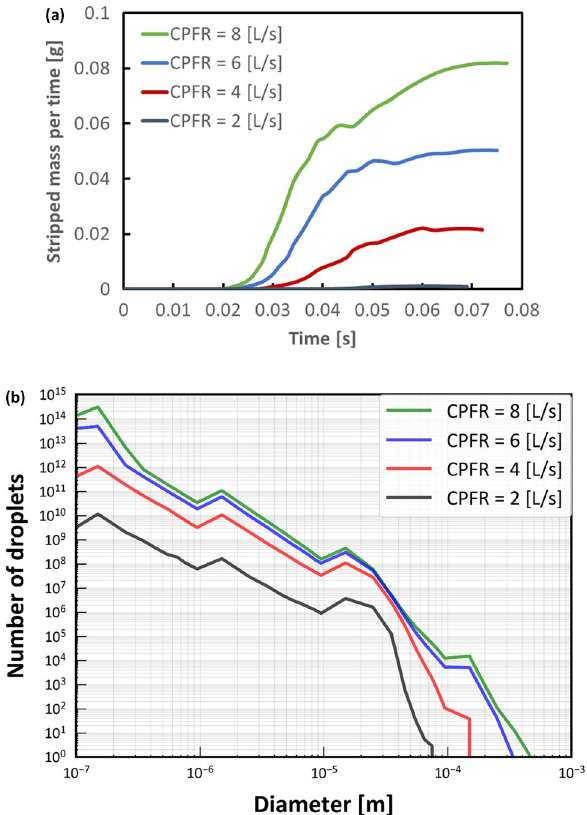
Figure 7. Particle stripping with different CPFRs. ( a ) Stripped particle mass of the mucous film for each time step. ( b ) Particle size distribution of droplets generated with different